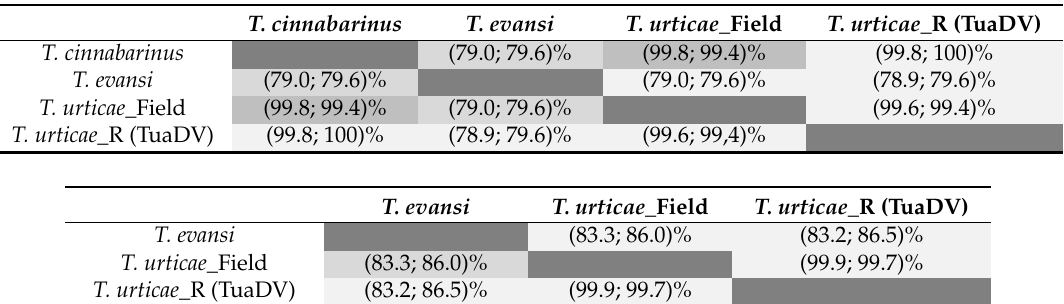
Table 3. Percentage identity (DNA; aa) between the TuaDVs. Upper panel . VP1 coding sequence (CDS)/protein isolated from field populations. Lower panel NS1 CDS/protein isolated from field